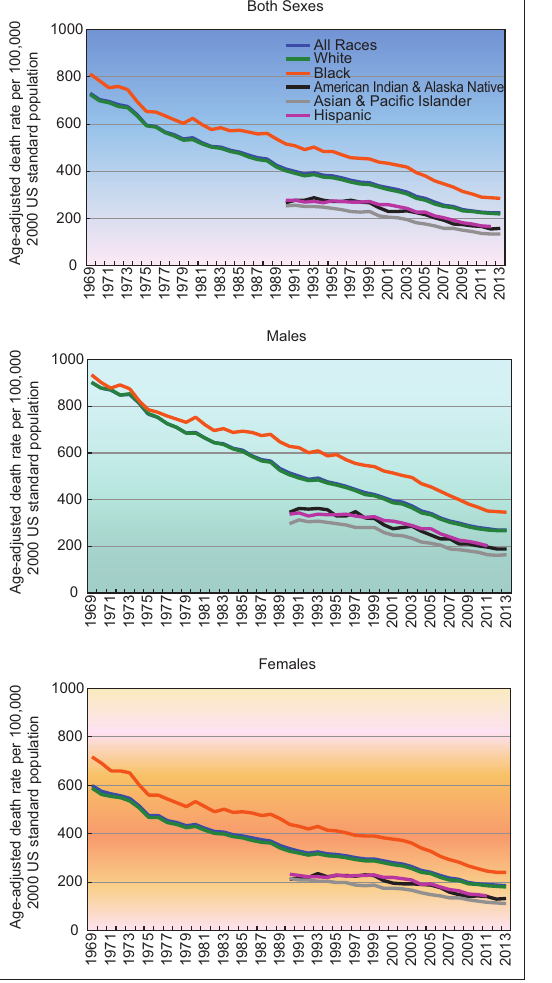
Figure 2 . Trends in Cardiovascular Disease (CVD) Mortality by Race/Ethnicity and Sex, United States,